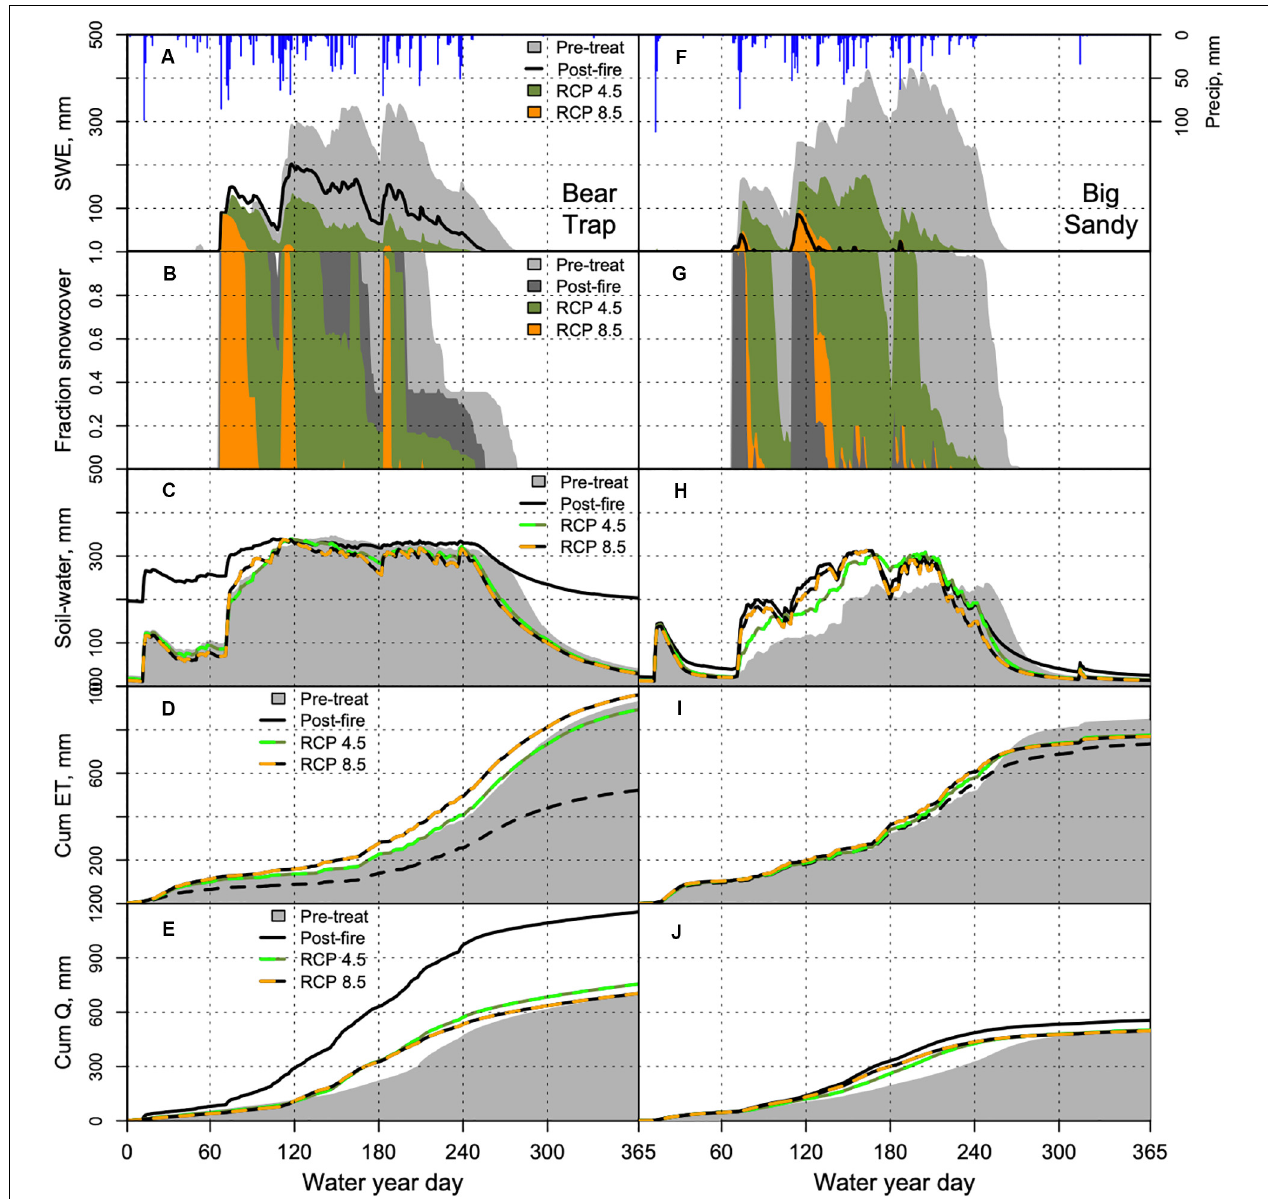
FIGURE 5 | Daily precipitation and snowpack storage (A,F) , basin snow-cover fraction (B,G) , soil-water storage (C,H) , evapotranspiration (D,I) , and stream discharge (E,J) in the Bear Trap and Big Sandy catchments with vegetation and temperature perturbations. Vegetation densities are from control and post-fire conditions, and temperature increases are from year 2100 projections with RCP 4.5 and 8.5 climate scenarios.